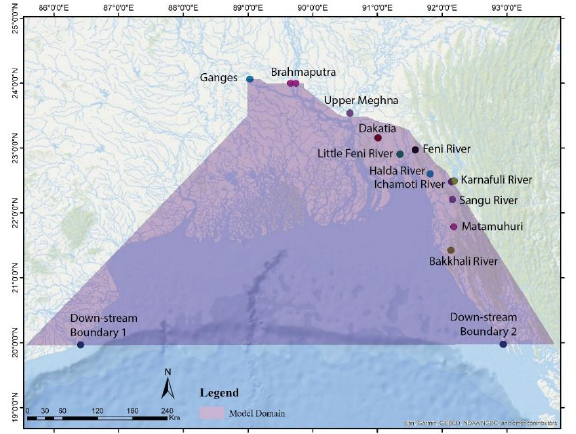
Figure 2. Upstream and downstream boundary of the model.